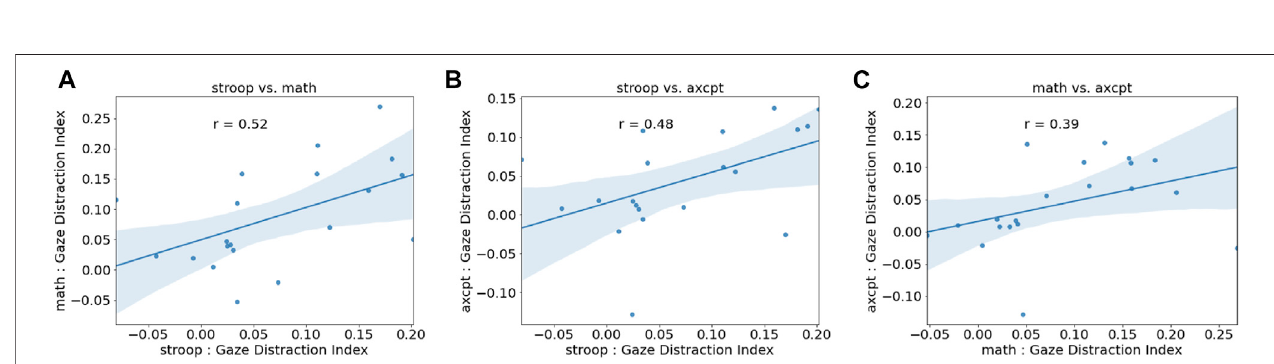
FIGURE5| Distractionindicesbytaskcalculatedaschangeinbehavioronceadistractorappeared. (A) Gazedistractionindex,calculatedasthechangeinpercent time spent looking at the whiteboard once a distractor appeared, during each task. There were no differences in gaze distraction by task, ns = not signi fi cant. (B) Performance distraction index, calculated as the change in the percent of problems responded to once the distractor appeared, during each task. (C) Signi fi cant correlation between gaze and performance distraction indices indicates that participants who looked away from the whiteboard more when distractors appeared also completed fewer problems. This provides an empirical link between eye gaze on the whiteboard and ability to complete problems, across all task types.